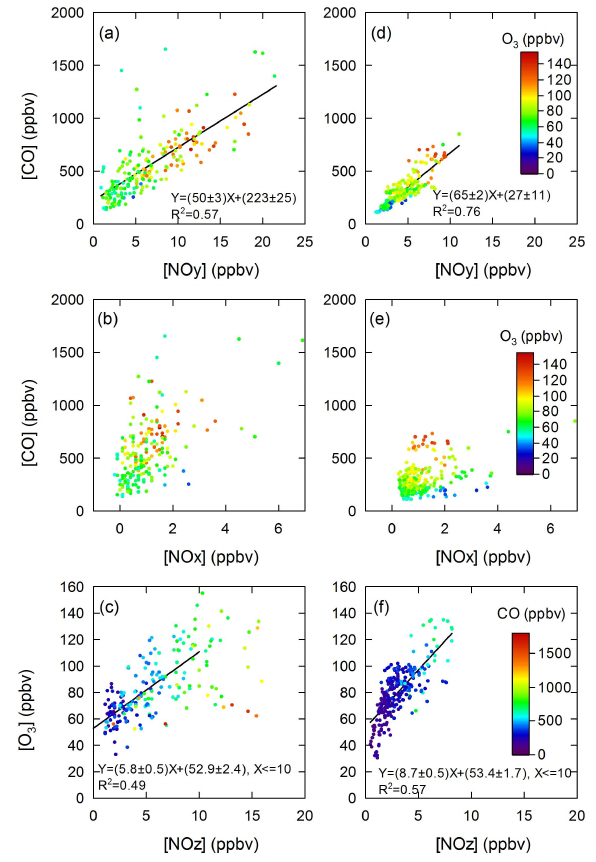
Fig. 4. Observed correlations between (a) NO y and CO concentra- tions, (b) NO x and CO concentrations, and (c) NO z and O 3 concen- trations. Symbols are colored by O 3 concentrations for (a) and (b) , and by CO concentrations for CO. (d–f) same as (a–c) but using modeled